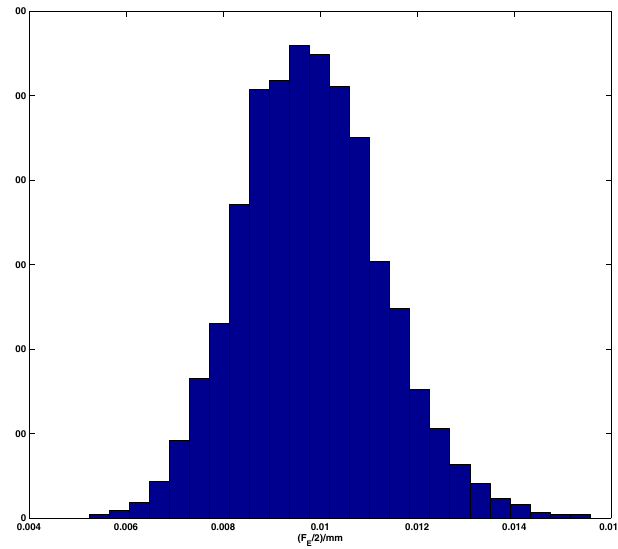
Fig. 5. Sampled form error F E,q / 2 calculated as in equa- tions (18) and (19) for data shown in Figure